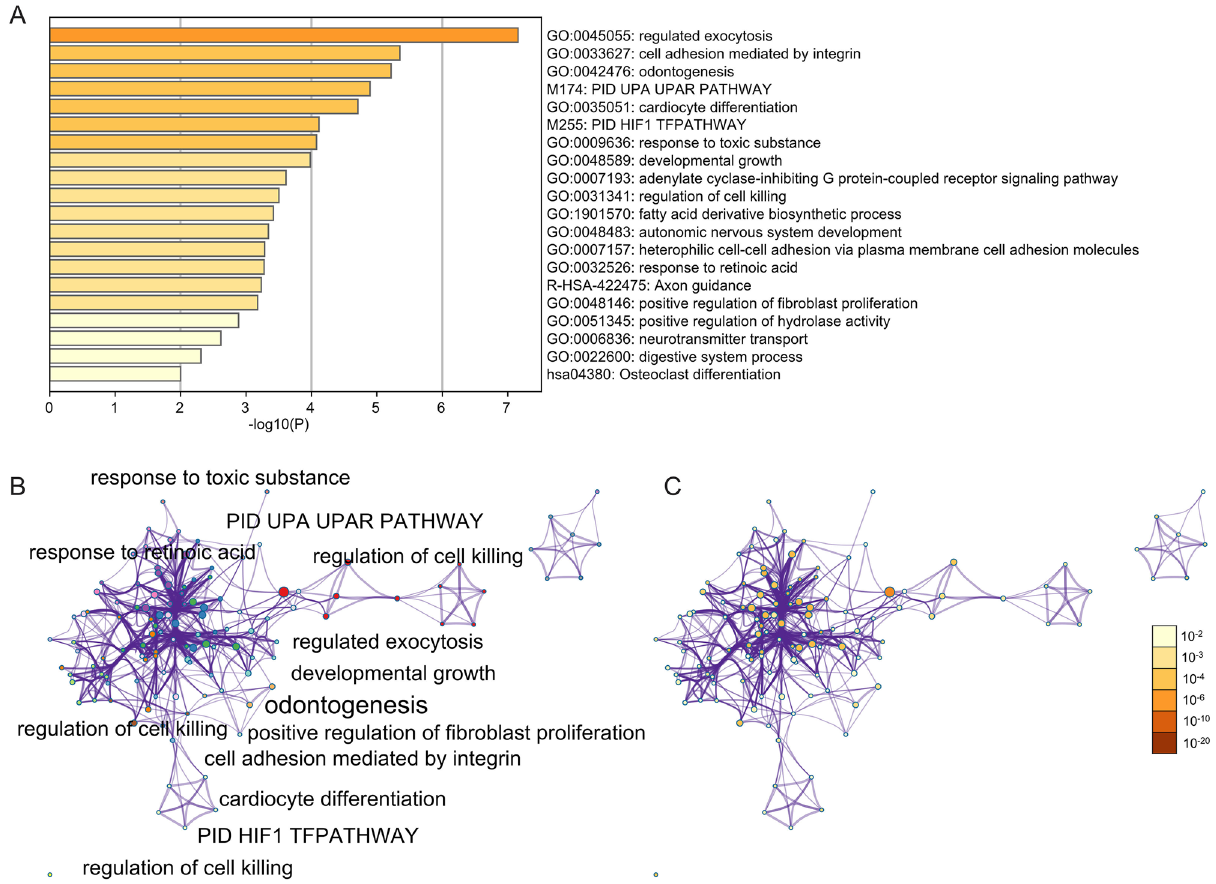
Figure 2. Enrichment analysis for the DEGs by Metascape. ( A ) Heatmap of enriched terms across input differently expressed gene lists, colored by P-values, via the Metascape. ( B ) Network of enriched terms colored by cluster identity, where nodes that share the same cluster identity are typically close. ( C ) Network of enriched terms colored by P-value, where terms containing more genes tend to have a more significant